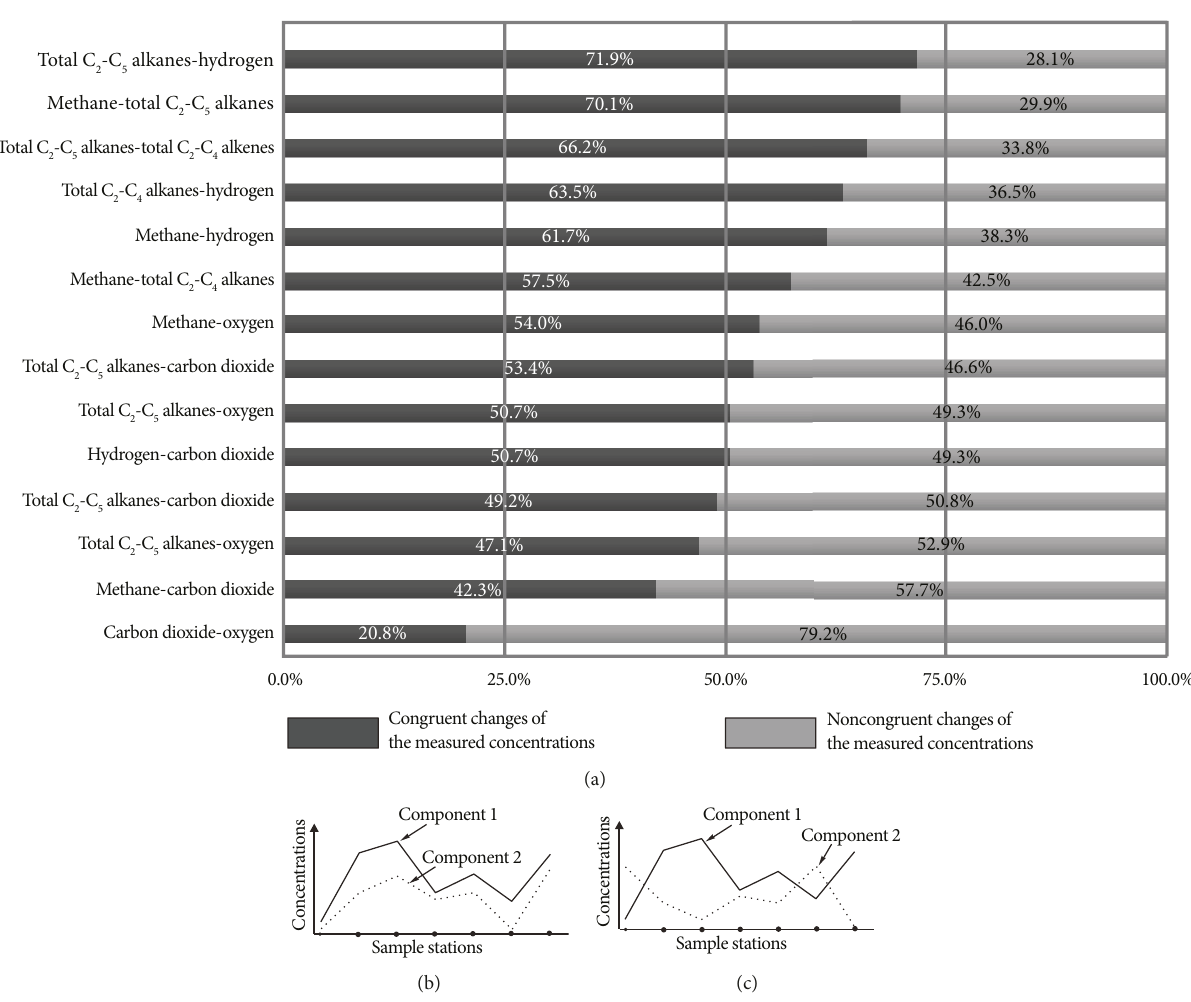
Figure 3: Correlation trends between analyzed components of soil gas (a). Examples of 100% consistency trends (b) and 100% inconsistency trends (c) of concentration changes for component pairs between succeeding sampling